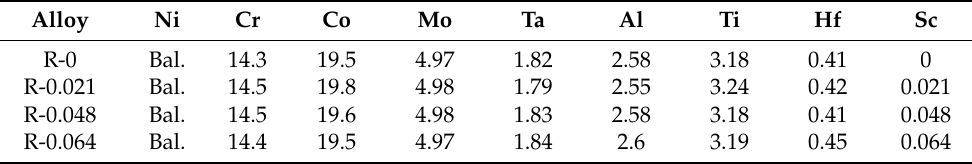
Table 2. Chemical composition of Sc-doped RR1000 powder in wt.%.